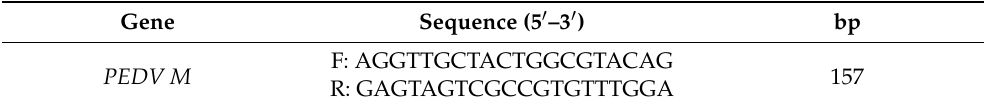
Table 3. Primer sequences for the PEDV M